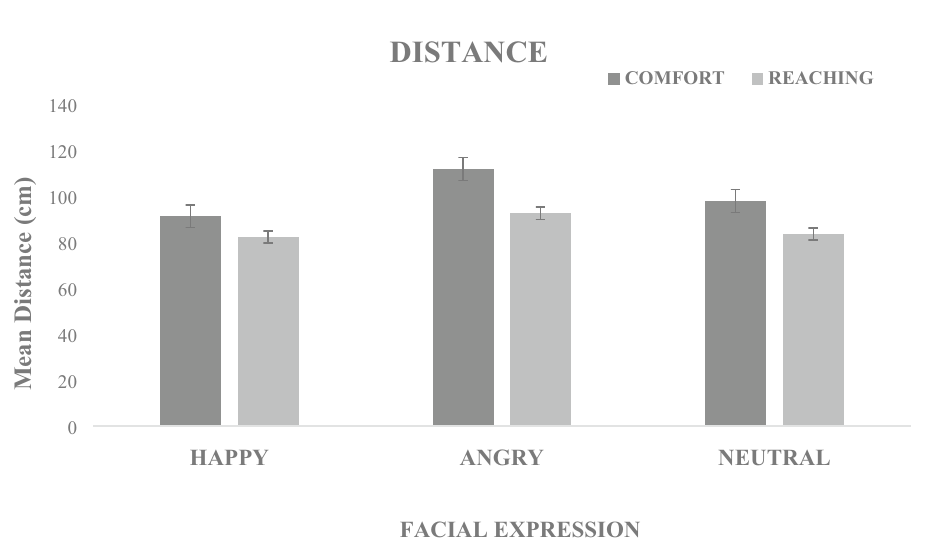
Figure 3. Effect of Facial expression on distance. The graph shows the mean distances (cm) as a function of the three facial expressions (Happy-Angry-Neutral) in the comfort and reaching distance tasks. Error bars represent the standard